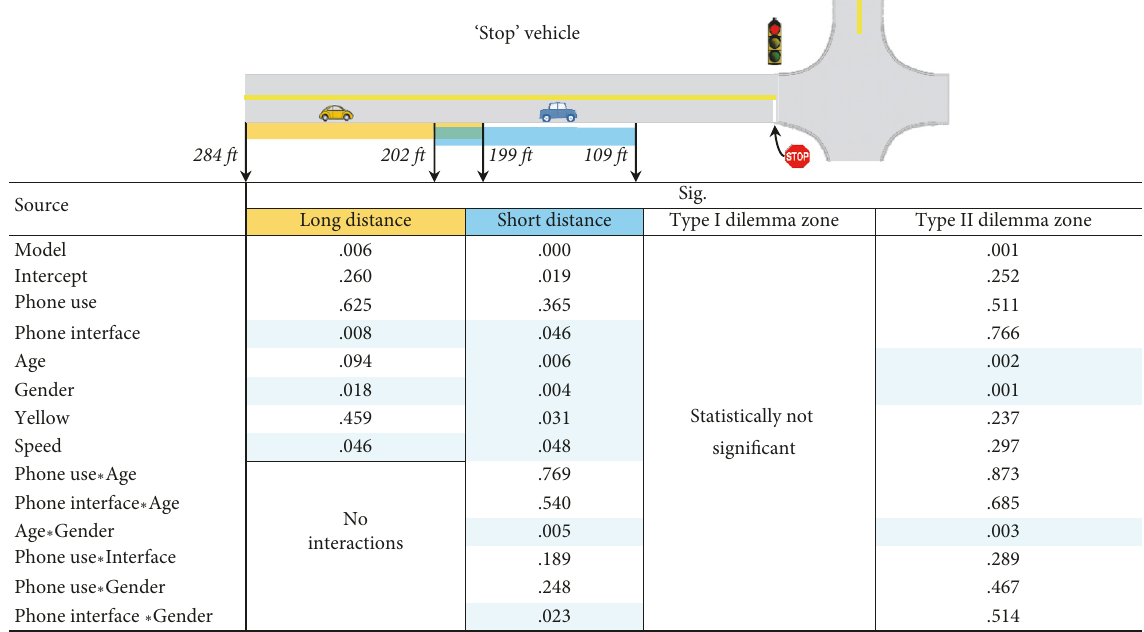
Figure 5: Different distances to stop line (Stop).